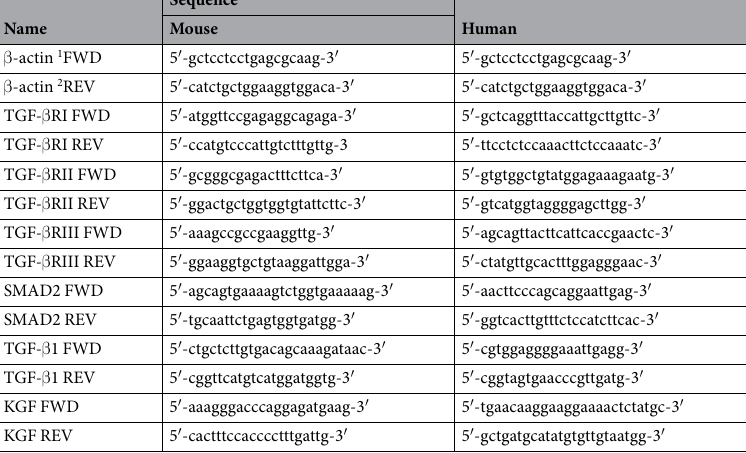
Table 2. Primer Sequences. 1 FWD: forward, 2 REV: